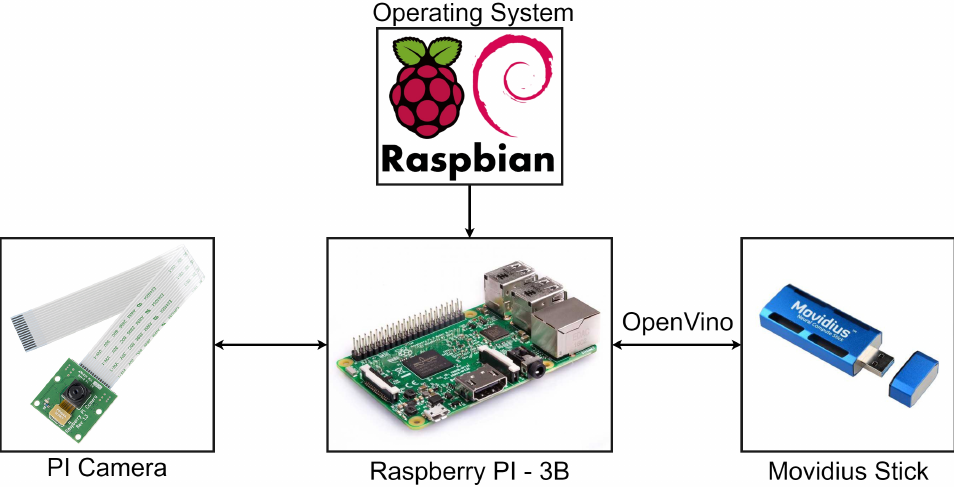
Figure 8. Schematic for the